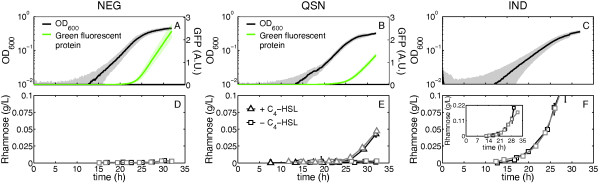
Average growth curves, GFP expression and rhamnose secretion in strains NEG, QSN and IND. A) Average growth of NEG cells (black) with standard deviation (gray), inoculated at 0.0025 OD600 over two independent experiments. Average GFP expression, under the control of the PA01 rhlAB-promoter (green) with the standard deviation (light green) constructed from the same experiments. B) Average growth of QSN cells in the presence of 5 μM C4-HSL (black) with standard deviation (gray), inoculated at 0.0025 OD600 over two independent experiments. Average GFP expression, under the control of the PA01 rhlAB-promoter (green) with the standard deviation (light green) constructed from the same experiments. C) Average growth curve of IND cells (black) with standard deviation (gray), inoculated at 0.0025 OD600 over two independent experiments. NEG is not a reporter fusion strain, so there is no GFP expression. D) No rhamnose is detectable in NEG in two independent experiments (black and gray). E) Rhamnose is undetectable in QSN in the absence of C4-HSL in two independent experiments (black and gray squares), but is reconstituted in the presence of C4-HSL (black and gray triangles). F) Rhamnose secretion in IND in two independent experiments (black and gray squares). The inset shows the complete range of rhamnose secretion in IND cells under our experimental settings.